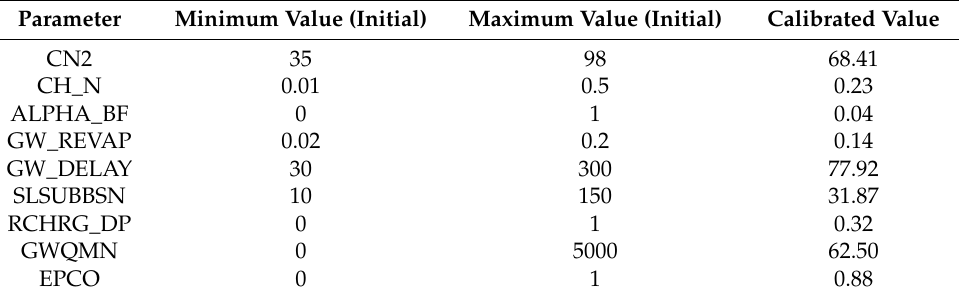
Table 4. Main hydrological parameters and values used in calibration.